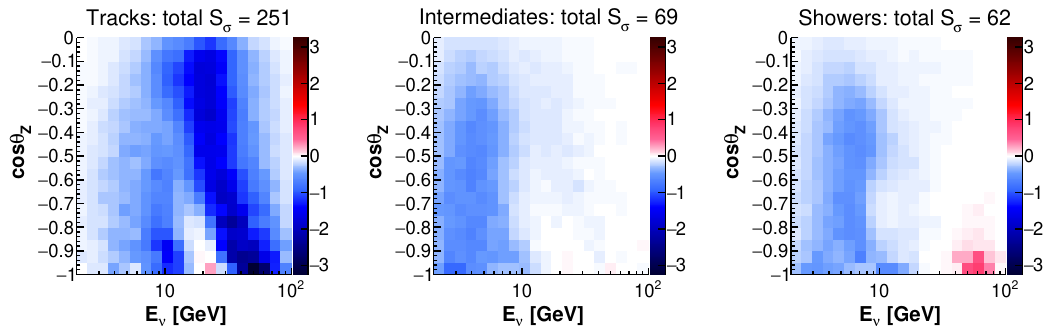
Figure 4 . S σ distribution of the three topologies considered in the analysis (tracks, intermediates and showers) assuming three years of data taking. The colour scale denotes the S σ value for each bin, whereas the total S σ is reported on top of the plots: the high value obtained is due to the normalisation. The sterile neutrino parameters are sin 2 θ 14 = 0 , sin 2 θ 24 = 0 . 03 , sin 2 θ 34 = 0 . 05 , ∆ m 2 = 1 eV 2 41